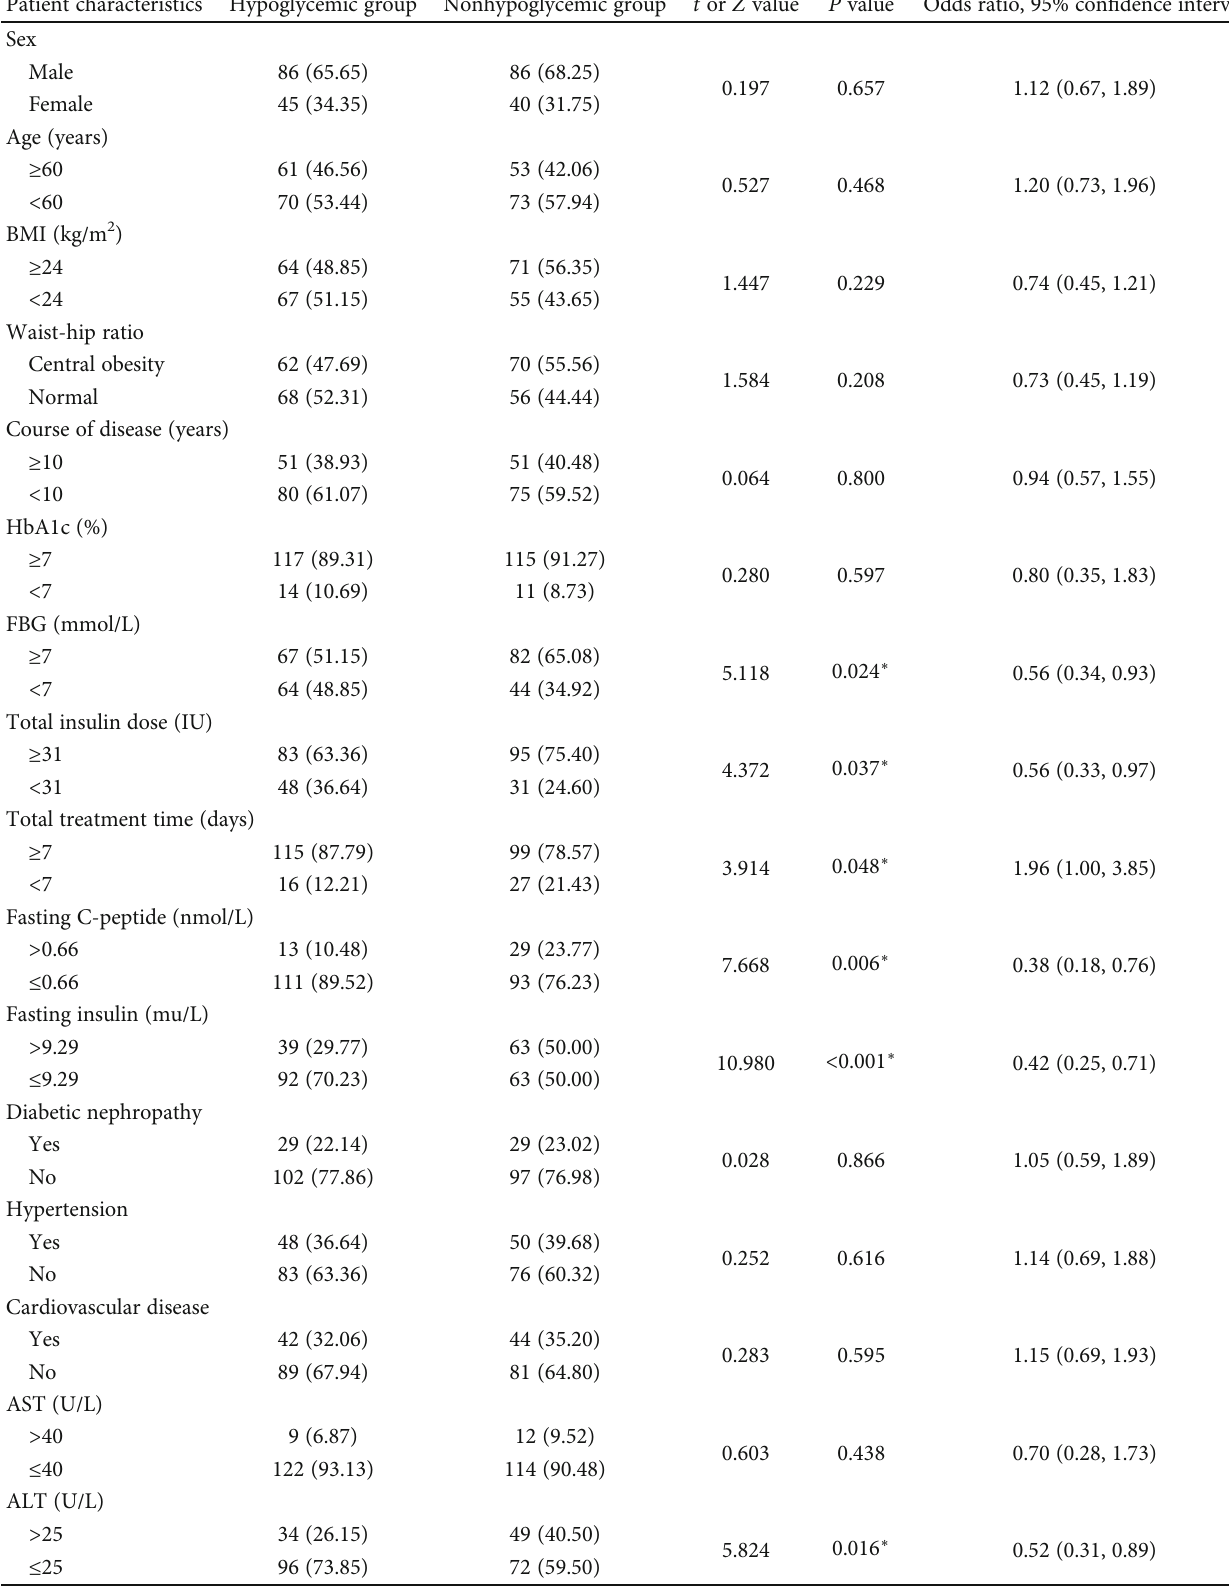
Table 1: Comparison of the demographic and clinical characteristics of the hypoglycemic and nonhypoglycemic